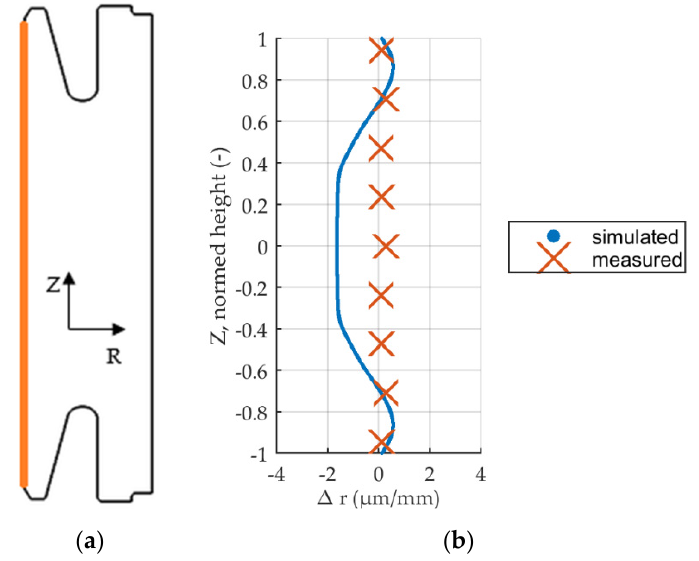
Figure 8. Relative displacement after press out, nominal mandrel diameter. Comparison of measured and simulated profiles. ( a ) Measurement location. ( b ) Comparison of profiles.